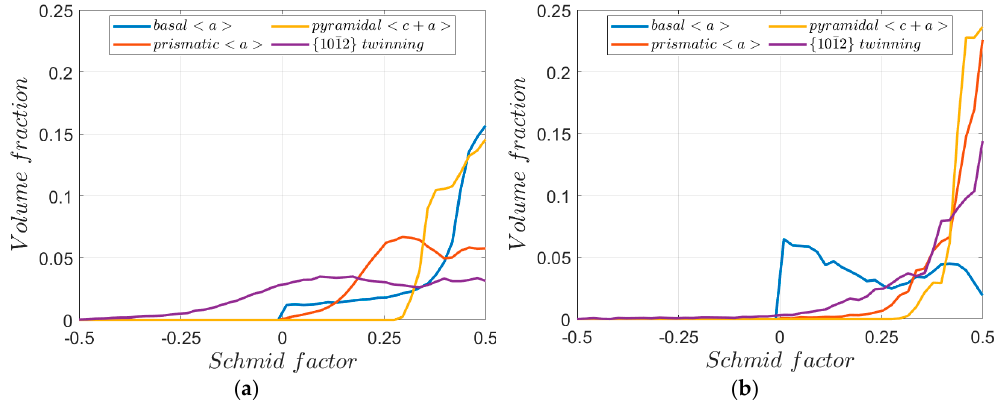
Figure 11. Schmid factor (SF) distribution calculated for major deformation mechanisms during the compression loading along the ED of ( a ) as-extruded sample (EX) and ( b ) 8P